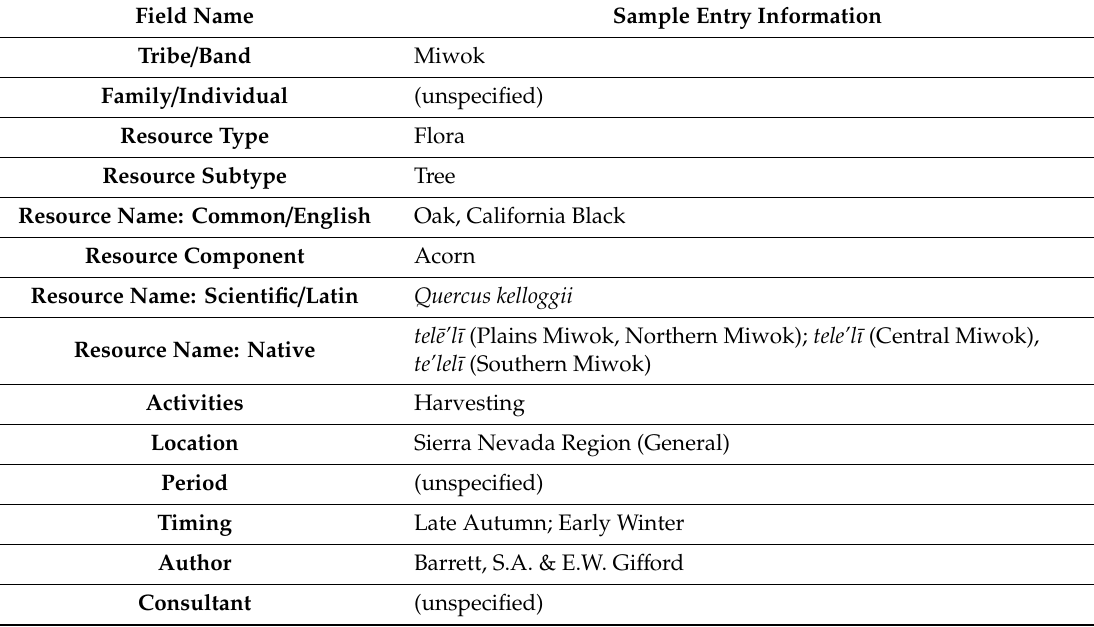
Table 3. Sample Entry in Database Demonstrating how Information Derived from the Text is Organized by